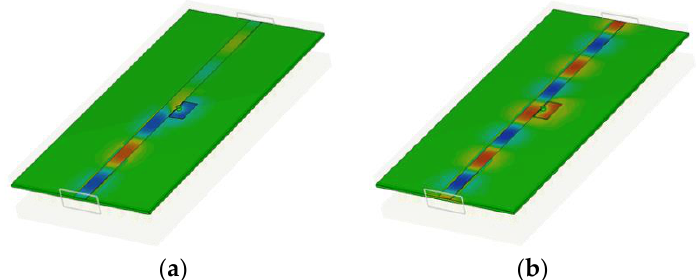
Figure 6. Simulated Ez field component for the 1 cell resonator (rx = 4.8 mm, ry = 6.5 mm gx = 0.2 mm and r = 0.8 mm) response at frequency ( a ) f = 10.45 GHz ( b ) f = 11 GHz.